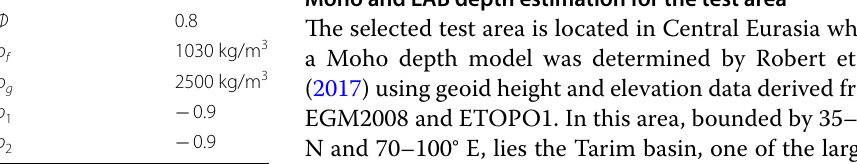
Table 2 Parameters used in the computation of the effect of sediment on elevation Parameter Symbol Value Effect of porosity